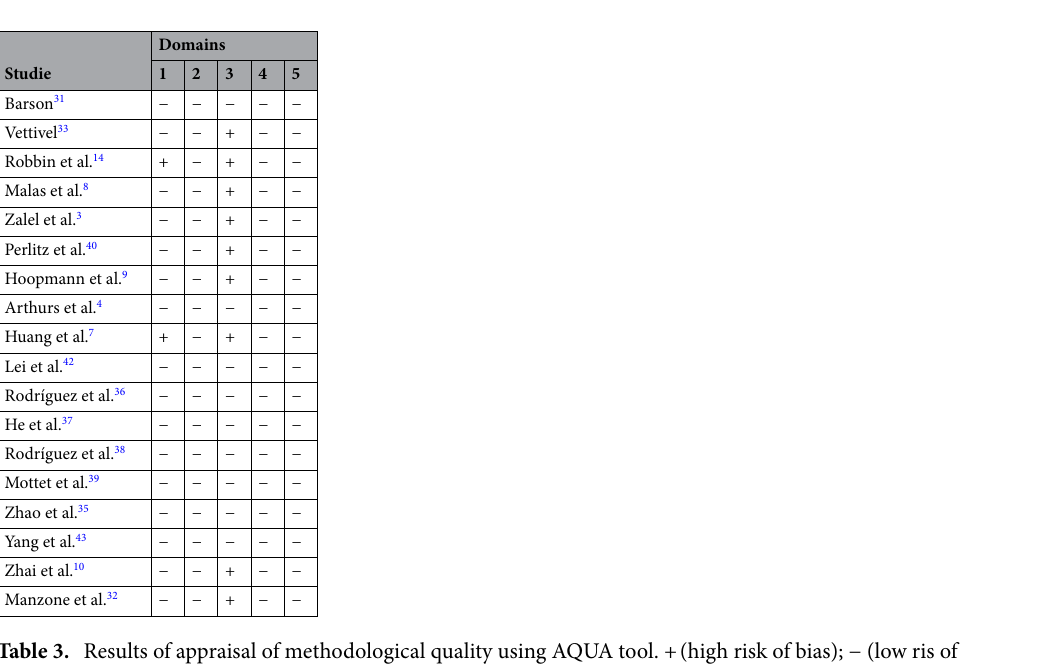
Table 3. Results of appraisal of methodological quality using AQUA tool. + (high risk of bias); − (low ris of